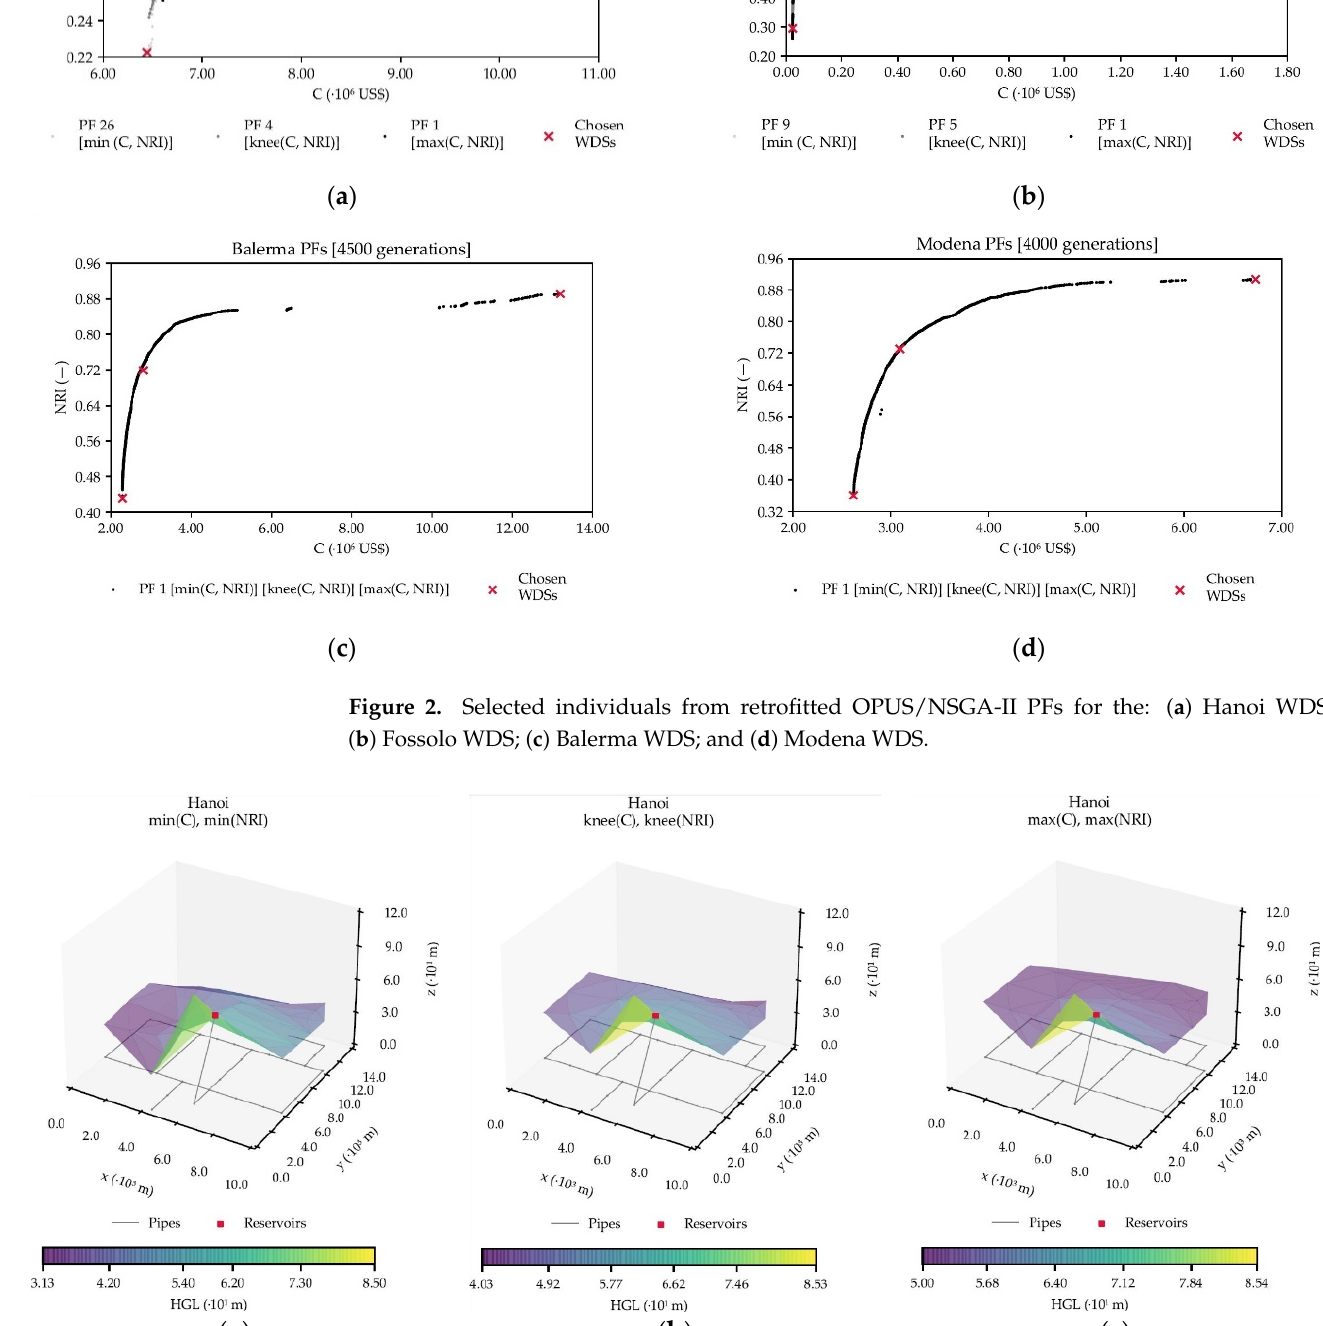
( c ) Figure 4. Fossolo WDSs with the corresponding HGL surfaces for the: ( a ) [min( C ), min( NRI )]; ( b ) [knee( C ), knee( NRI )]; and ( c ) [max( C ), max( NRI )] configurations. 4.3. Balerma Balerma is a WDS representing the irrigation system of the Poniente District located in Almeria, Spain [37]. The WDS consists of 454 pipes and 443 demand nodes supplied by